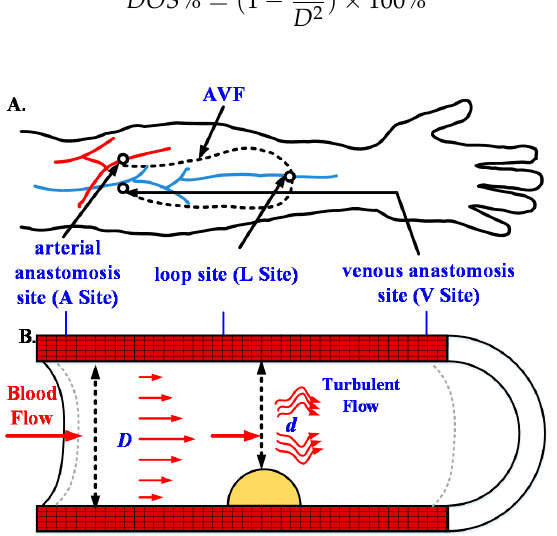
Figure 2. Schematic diagram of ( A ) the arteriovenous fistula (AVF) and ( B ) the degree of stenosis (DOS) parameters.